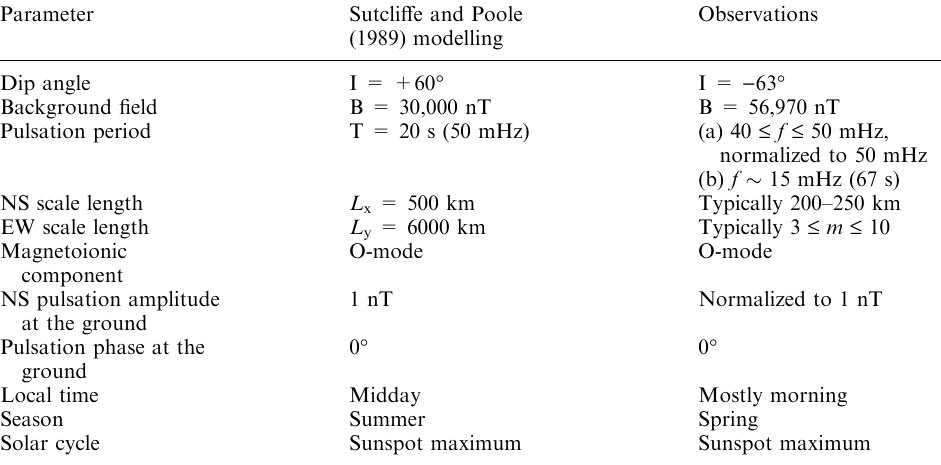
Table 1. Parameter set used for Figs. 11 and 12